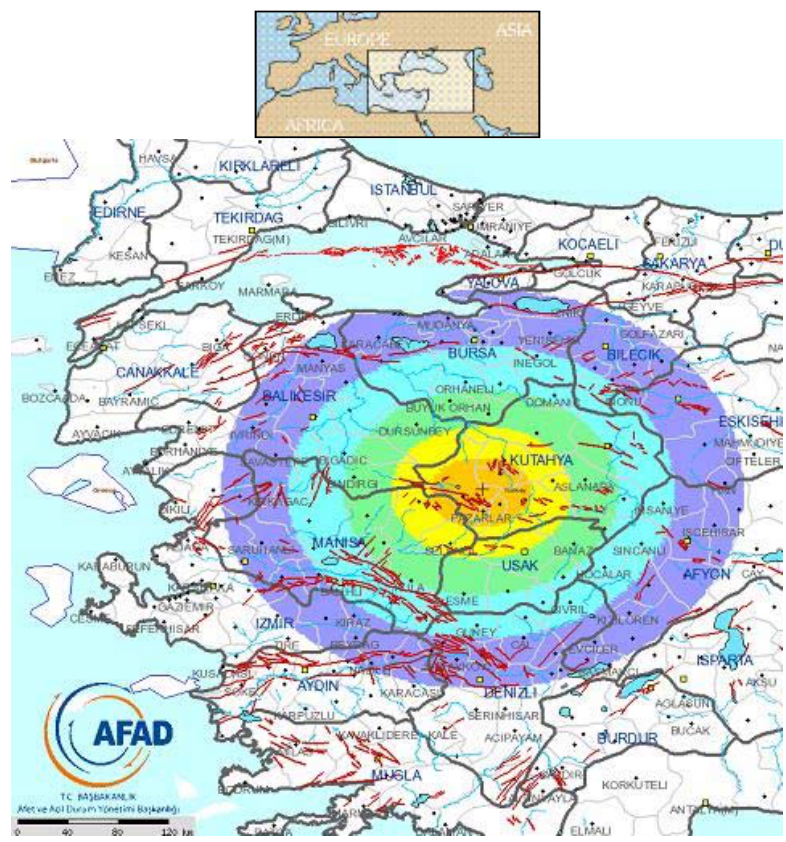
Figure 1. Seismic intensity map of Simav, Kutahya earthquake [3] (orange color in the center corresponds to Mercalli scale VII, and the outer most circle corresponds to scale II).